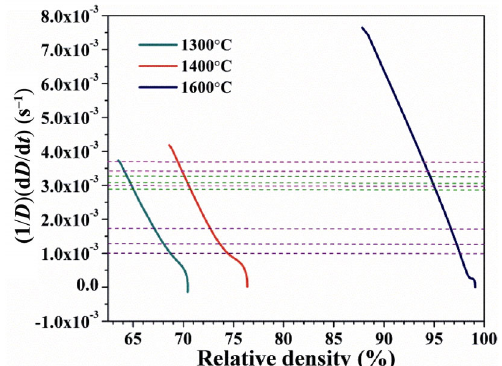
Fig. 8 Densification rate as a function of relative density. Three groups of densification rate values are chosen, denoted by pink, purple, and green dotted lines, with purpose of calculating the apparent activation energy ( Q d ) at different temperatures. The corresponding σ eff and μ eff can be obtained according to relative densities upon the 1 d D fixed values of d D t